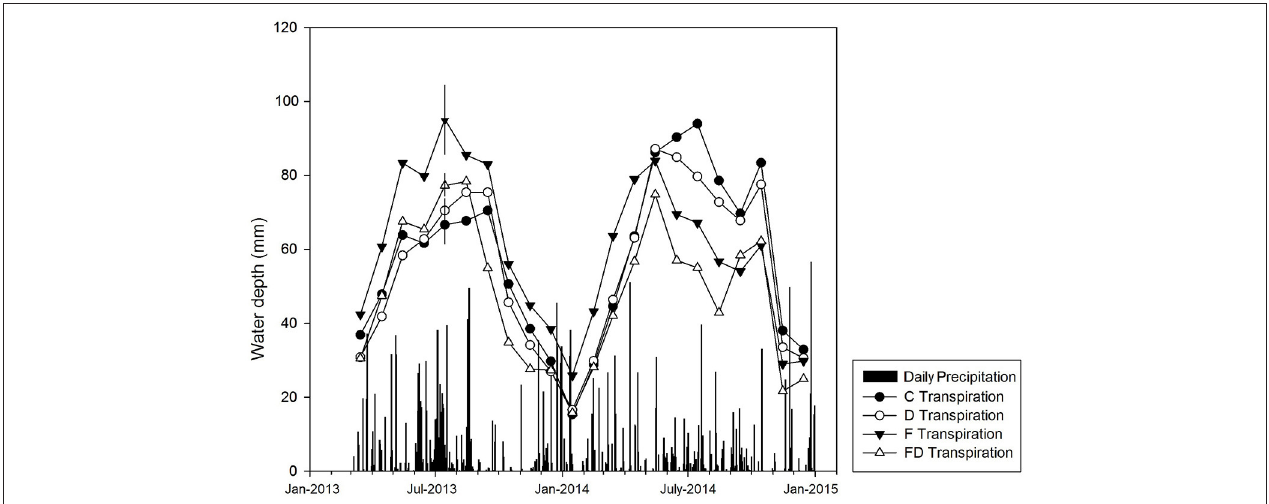
FIGURE 3 | Daily precipitation (black bars) and monthly transpiration in treatments of control (C), fertilization (F), throughfall reduction (D), and combined treatment of FD in a loblolly pine plantation in Taliaferro County, Georgia for the period of March 2013 to December 2014. Error bars ( ± 1 SE, n = 4) shown only for July 2013 transpiration to maintain clarity. The transpiration was determined from sap flux measurements and scaling approaches detailed in Bartkowiak et al.